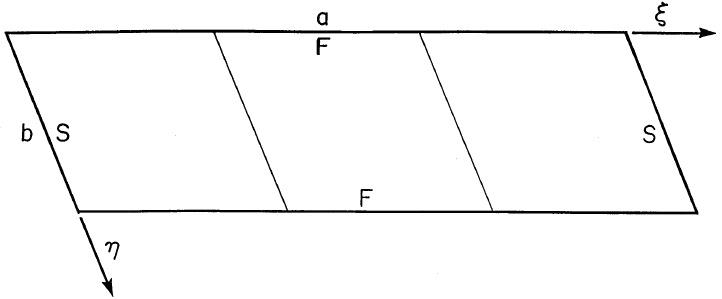
Fig. 5. Rectangular plate with opposite edges simply supported, and free. Transvers node lines are those of higher mode